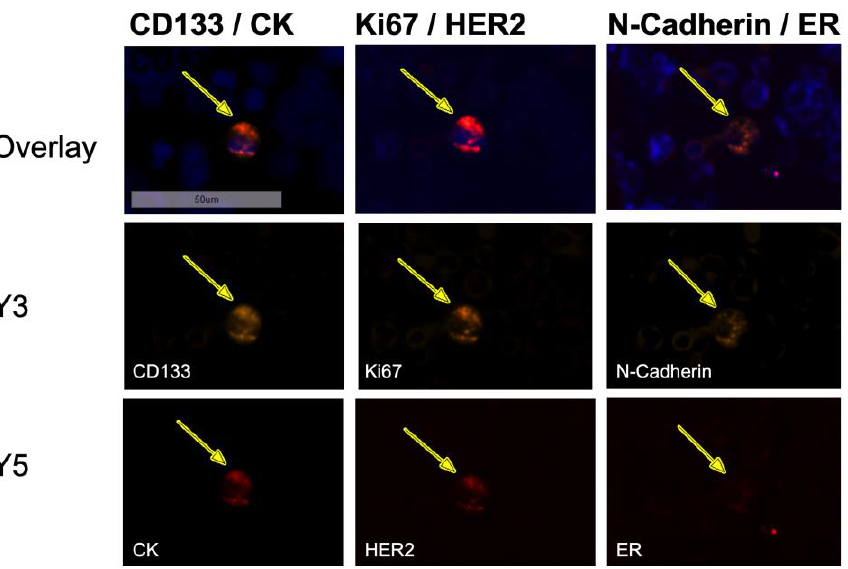
Figure 5. Sequential immunofluorescent staining of a disseminated tumor cell in the bone marrow of a patient exhibiting the profile CK+CD133+HER2+Ki67+Ncad+ at 20-fold magnification. The DTC expressed all stained markers (DAPI, CD133, CK, Ki67, HER2, N-cadherin) except ER, although the sample derived from a patient with an ER-positive primary tumor.